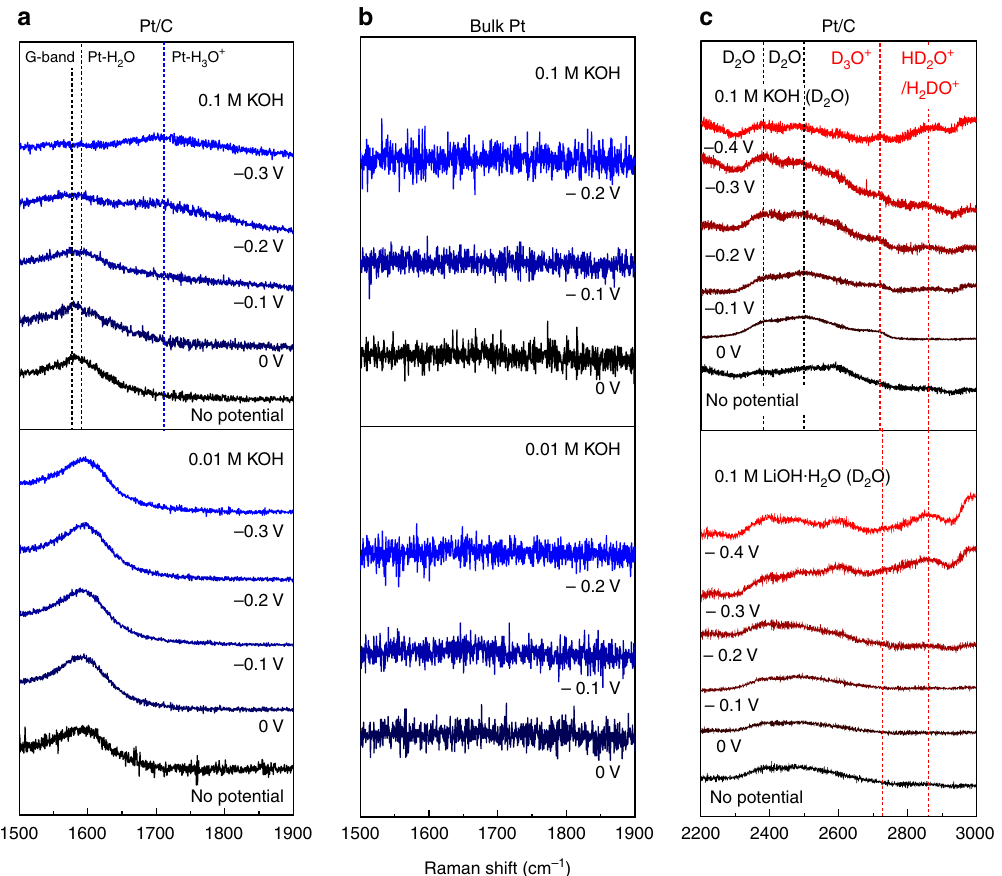
Fig. 3 Raman spectra of Pt/C and bulk Pt at various conditions. The Raman spectra for: a Pt/C and b bulk Pt in water-based alkaline environments. c Pt/C in deuterium water-based alkaline environments. The marked overpotential is in comparison to the onset potential of HER (e.g., − 0.1 V is 0.1 V more negative to onset potential). The Raman signals on the surface of the catalyst are identi fi ed as: G-band of carbon: ~1580 cm − 1 ; H 2 O: ~1600 cm − 1 ; H 3 O +